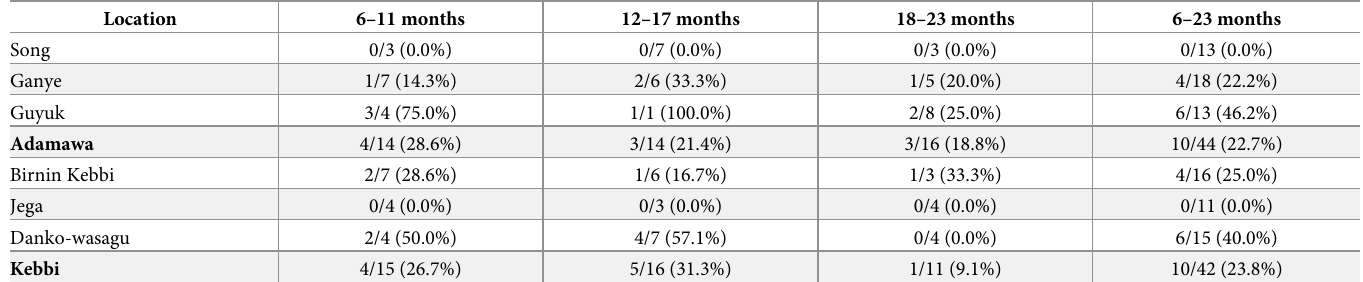
Table 4. Low-compliance MNP users ( > ± 4) according to spot check data by age group and location. Location